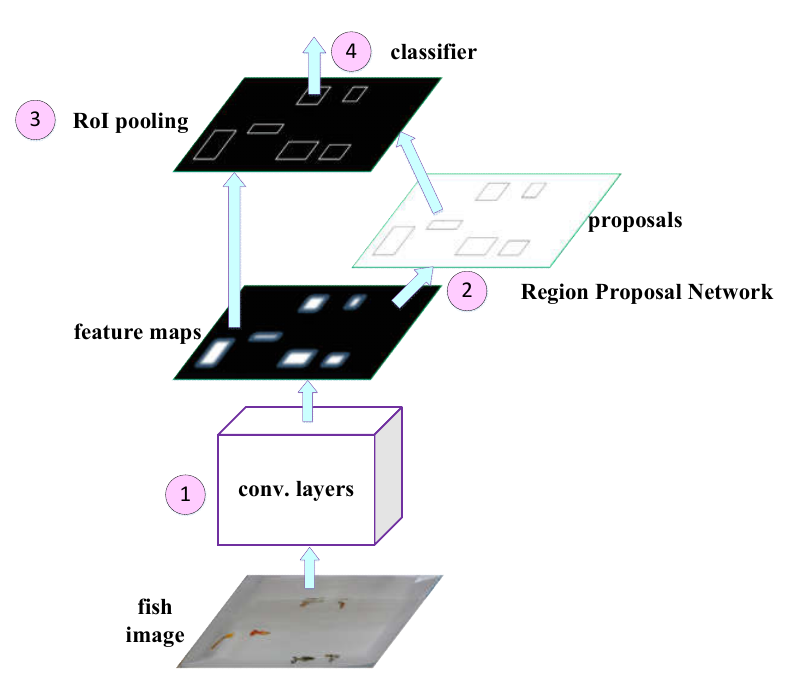
Figure 7. The architecture of the faster R-CNN model.